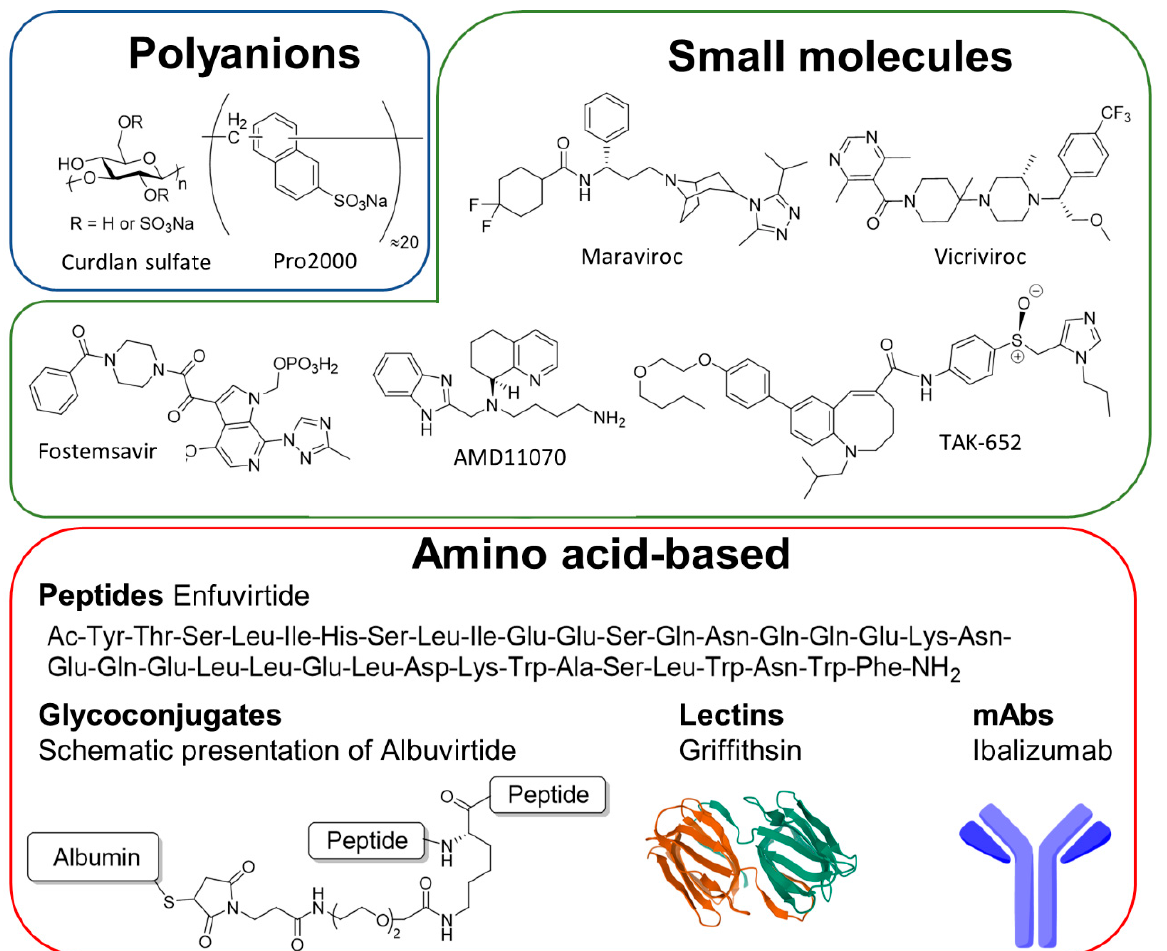
Figure 4. Entry inhibitors classified by chemical nature. Entry inhibitors can be classified chemically in three categories, the polyanions, the small molecules, and the amino acid-based inhibitors which included peptides, glycoconjugates, lectins and monoclonal antibodies (mAbs). Table 1. List of entry inhibitors tested in clinical trials to date.